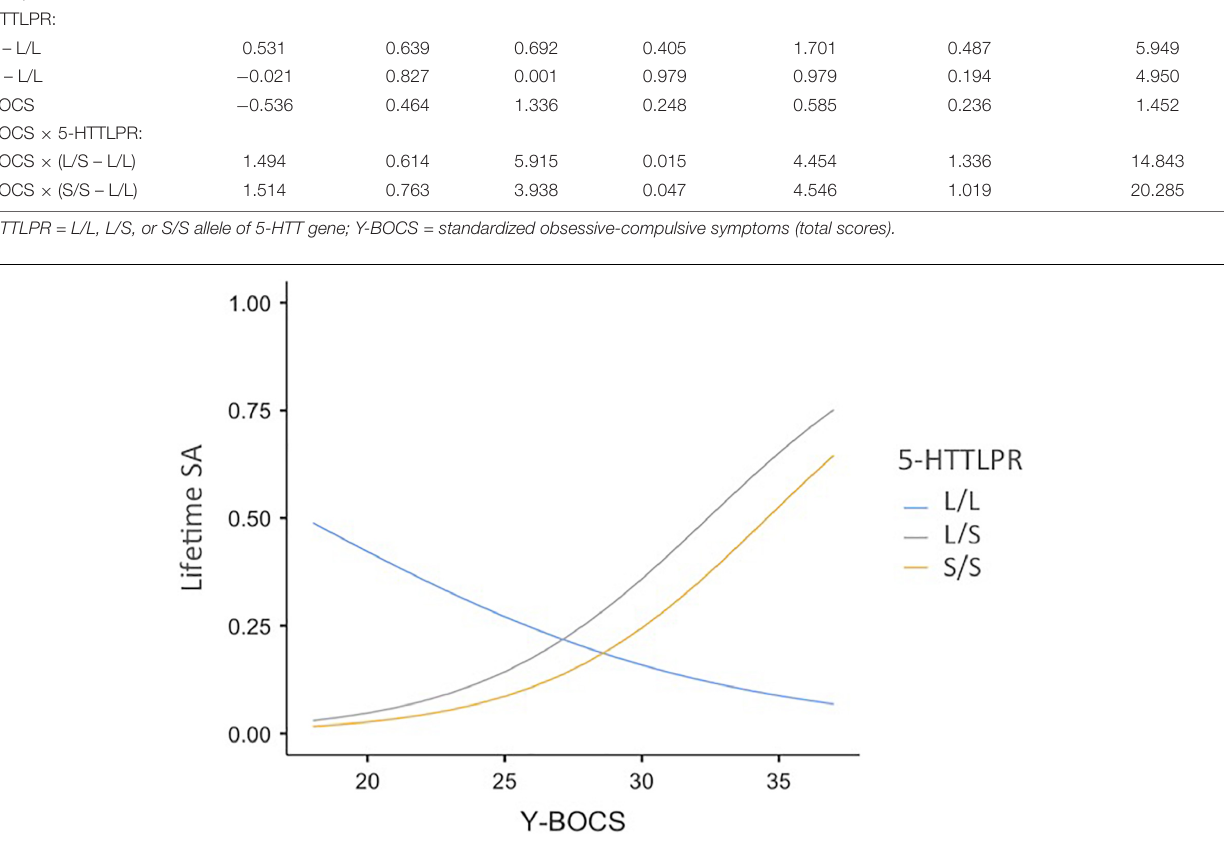
FIGURE 1 | Probability of a lifetime suicide attempt as a function of OCD symptom severity and 5-HTTLPR genotyping variations. 5-HTTLPR = L/L, L/S, or S/S allele of 5-HTT gene; Y-BOCS = obsessive-compulsive symptoms (total scores); Lifetime SA = Probability of a lifetime suicide